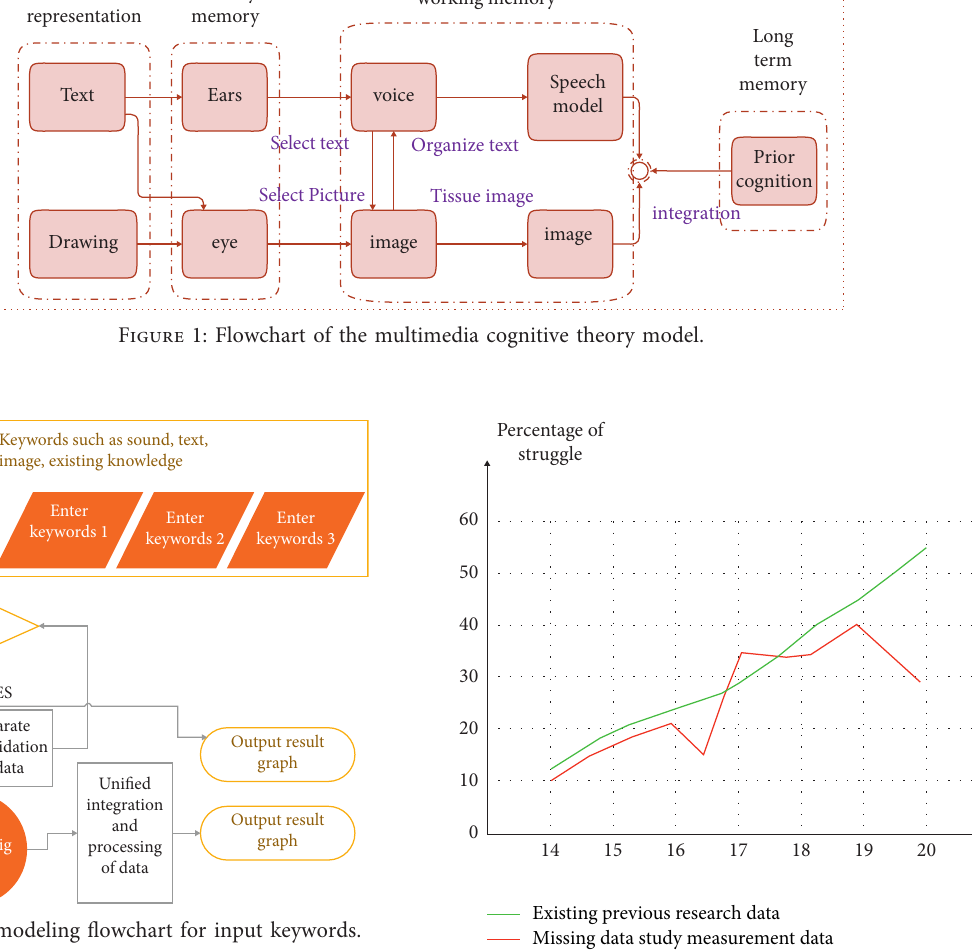
Figure 3: Comparison of existing data results and missing data studies.